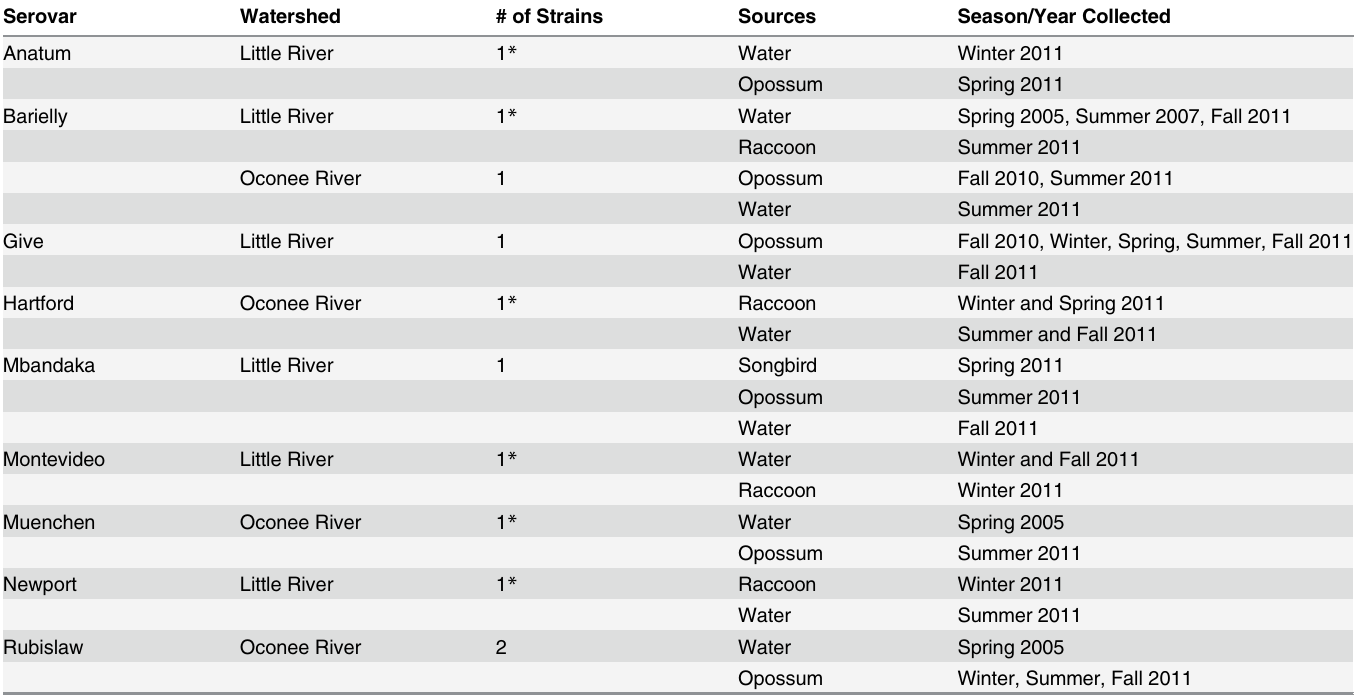
Table 2. Salmonella strains (PFGE types) present in both animals and water of the Little River or North Oconee River watersheds (Georgia, USA).